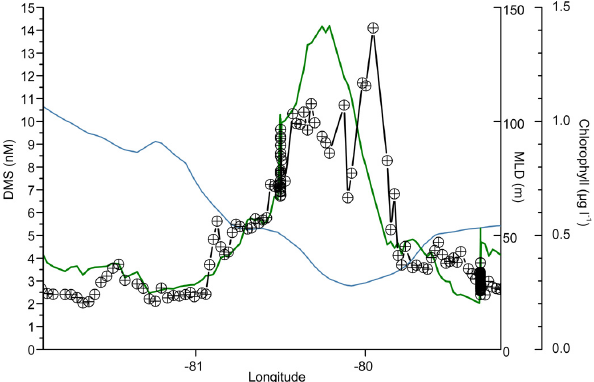
Fig. 3. The highest DMS concentrations were associated with a rapid shoaling of the mixed layer depth (MLD). Chlorophyll (green line) and DMS (black line, with crosshair symbols) concentrations increased as the MLD (blue line) shoaled. The data are plotted against longitude ( ◦ E). The latitude was ∼ 19 ◦ S. For reference, this is ∼ 1000km from the